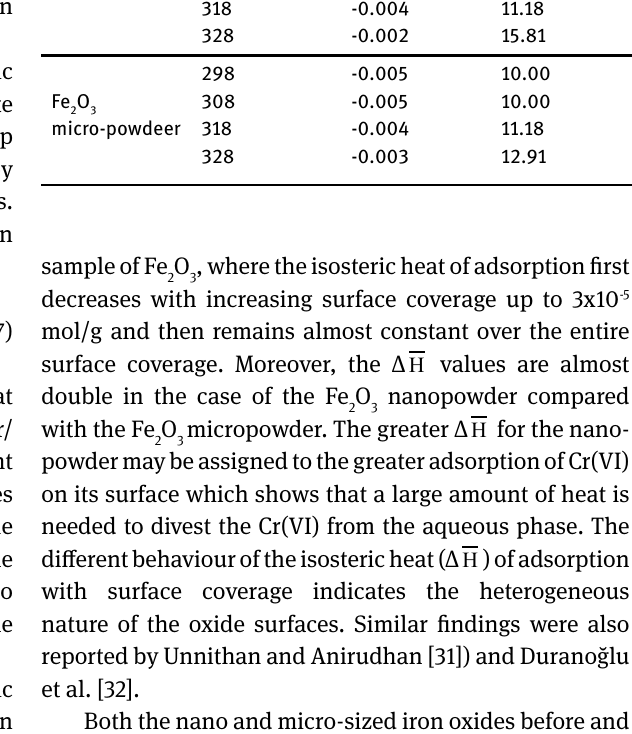
Table 3: D-R parameters for Cr(VI) adsorption by Fe